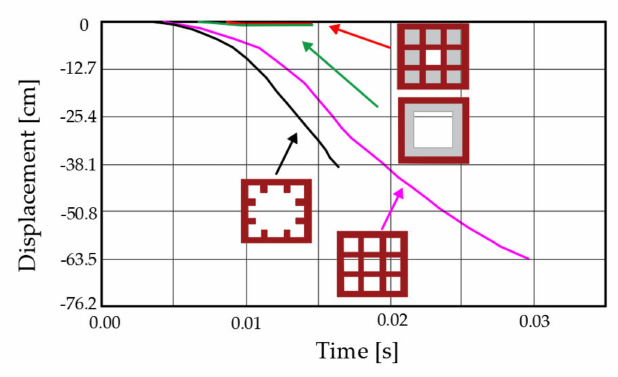
Figure 17. Time history of displacements for 4 column types [47].